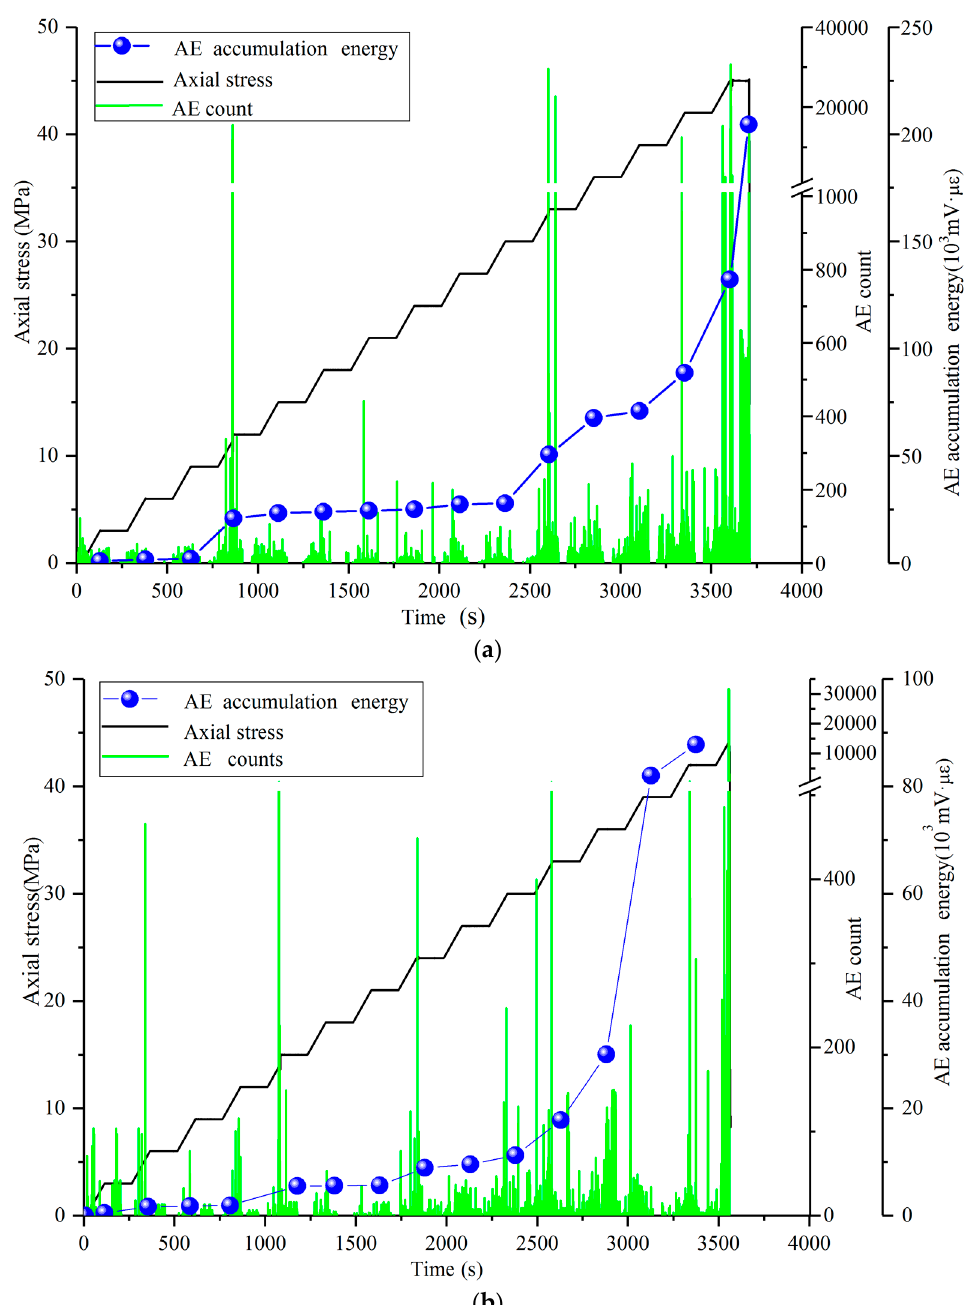
Figure 3. Sequential characteristics of granite AE parameter under grading loading. ( a ) intact rock sample; ( b ) holey rock sample.